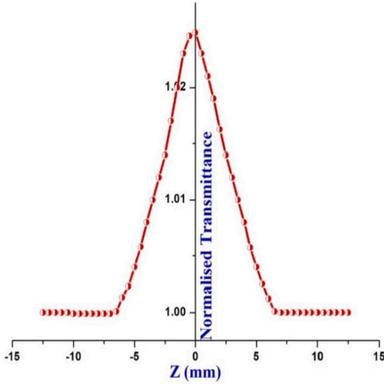
Z-Scan Transmittance curve for Open aperture.